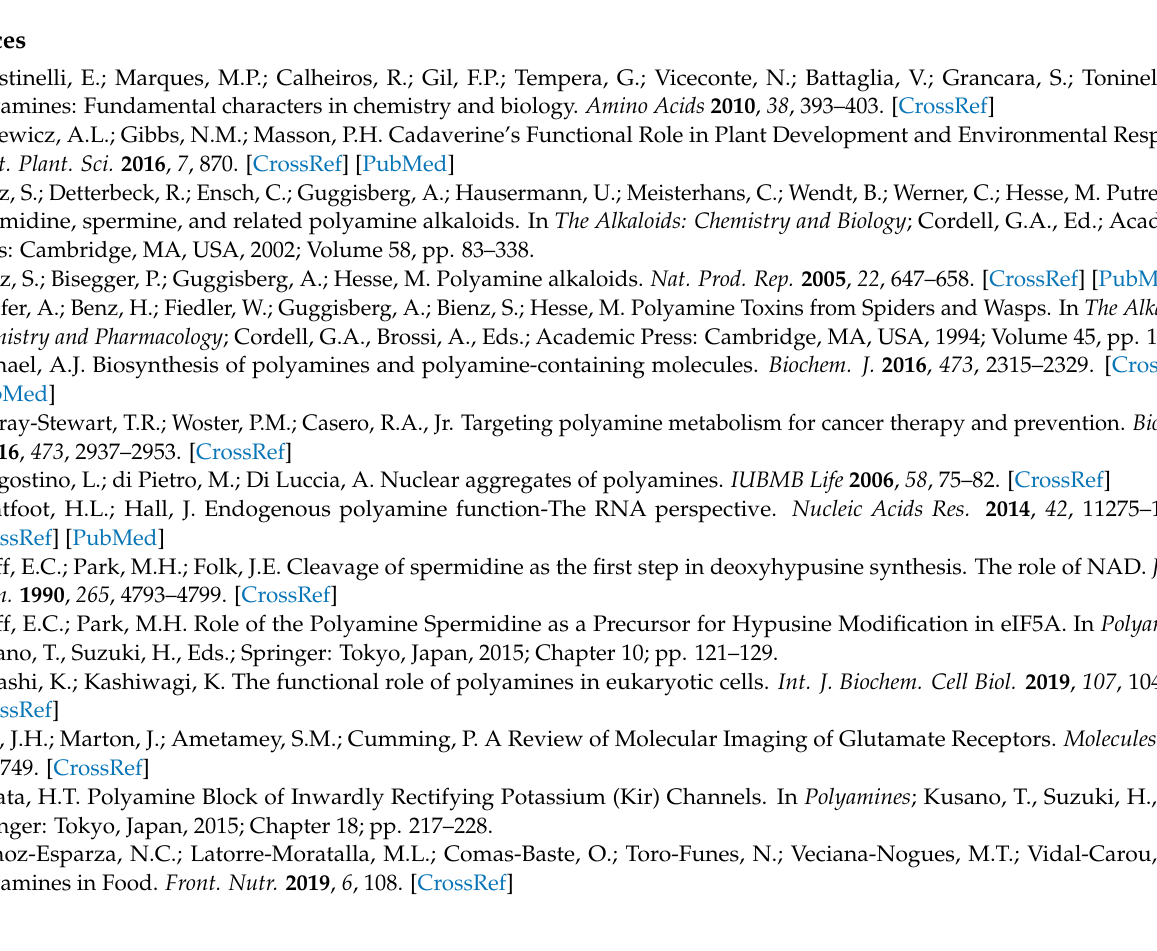
Supplementary Materials: Figure S1: ESI(+) mass spectrum after reduction of N 1 -Boc-3-oxospermidine, Figure S2: ESI(+) mass spectrum after fluorobenzoylation to N 1 -Dde- N 4 -FBz-spermidine, Figure S3: 1 H NMR spectrum of N 1 , N 1 -di(4-fluorobenzoyl)-1,6-diaminohexane × TFA, Figures S4–S39: 1 H and 13 C NMR spectra of all final